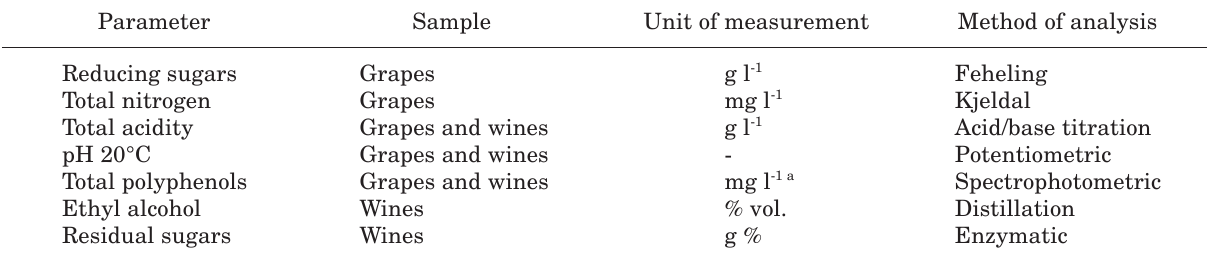
Table 1. Chemical analysis of cv. Trebbiano d’Abruzzo grapes and wines collected from symptomatic, diseased/ asymptomatic and healthy vines, and from restored vines with trunk renewal and healthy unrenewed vines in vineyards with